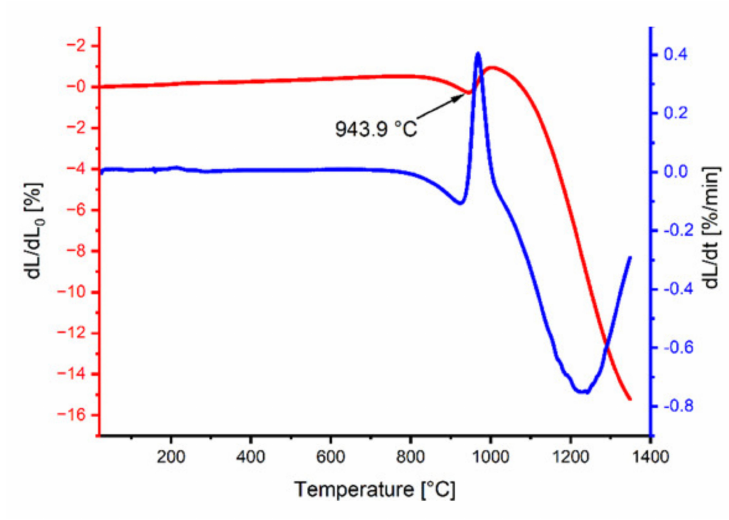
Figure 2. Dilatometric and derivative curves of the DyFeO 3 –Fe 2 O 3 mixture. Table 2. Relative density [% theoretical] of the sintered samples.